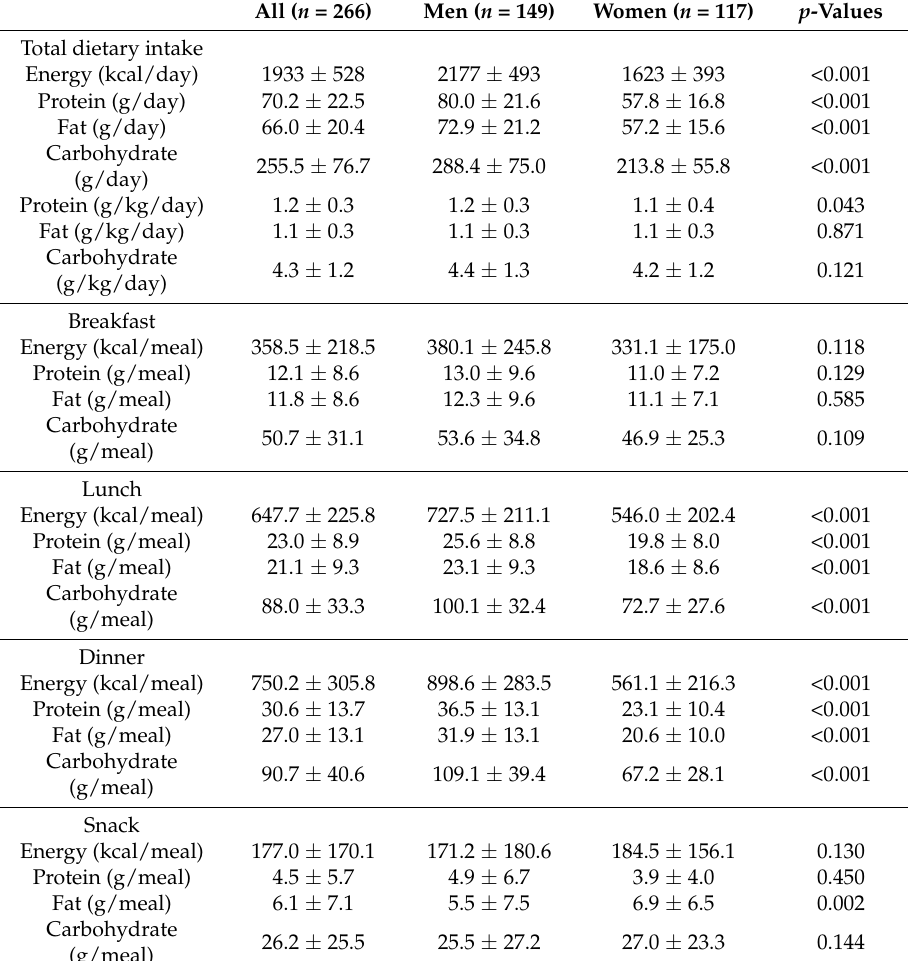
Table 2. Total dietary intake and dietary intake at each